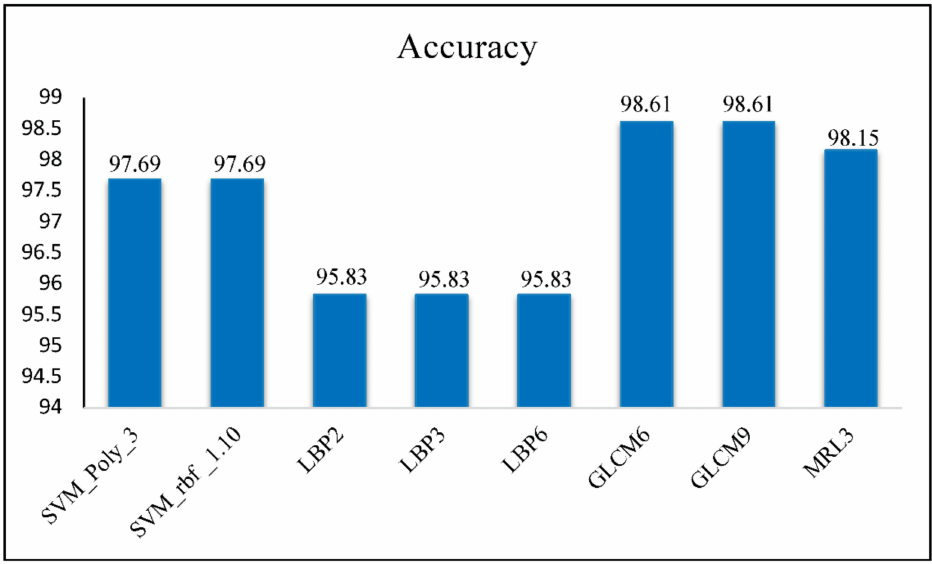
Figure 17. The best accuracy of geometric and texture